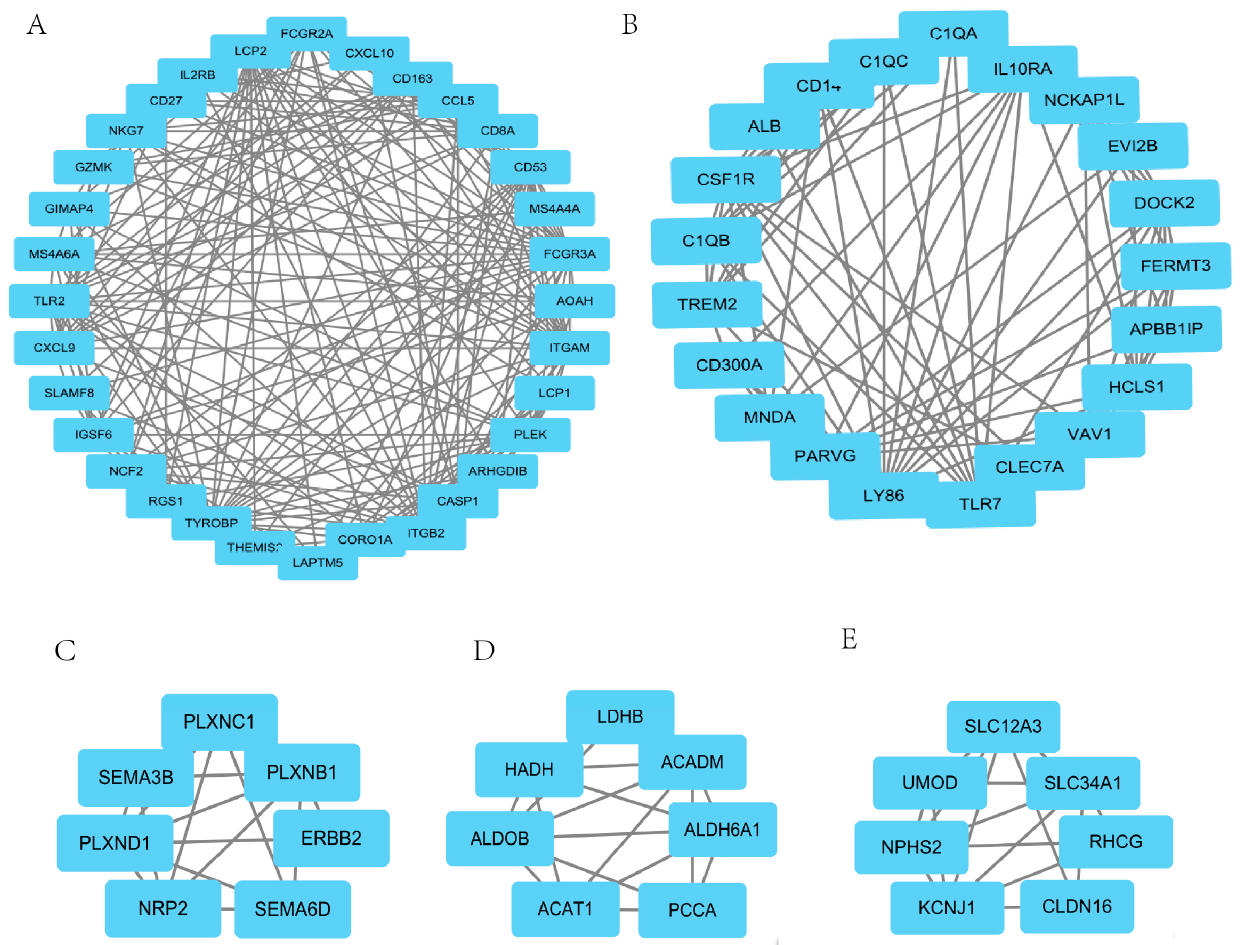
Figure 3. The PPI subnetwork with an MCODE score > 5.0. PPI subnetworks were extracted by the plugin MCODE. The clusters with MCODE scores > 5.0 are displayed. ( A ) The largest cluster with 32 genes, MCODE score 13.742. ( B ) The cluster with 21 genes, MCODE score 8.7. ( C ) The cluster with 7 genes, MCODE score 5.333. ( D ) The cluster with 7 genes, MCODE score 5.333. ( E ) The cluster with 7 genes, MCODE score 5.333.